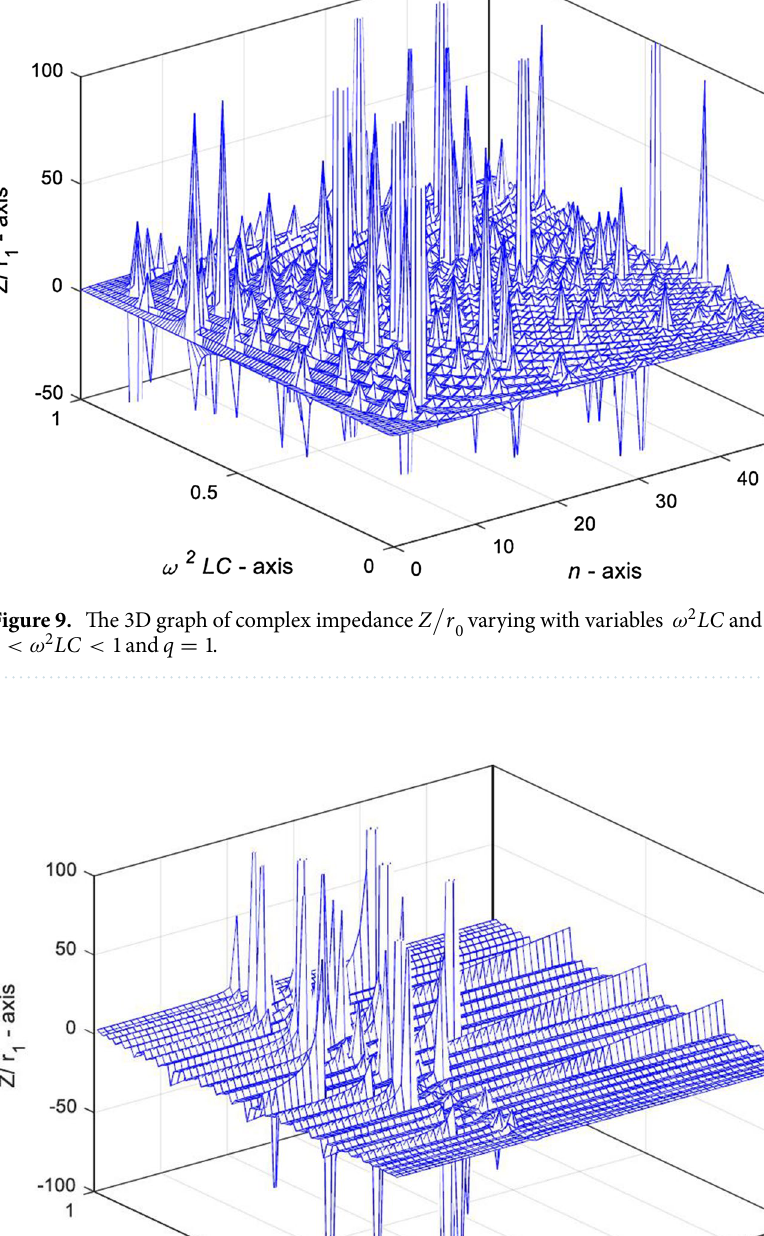
r 1 varying with variables (cid:31)